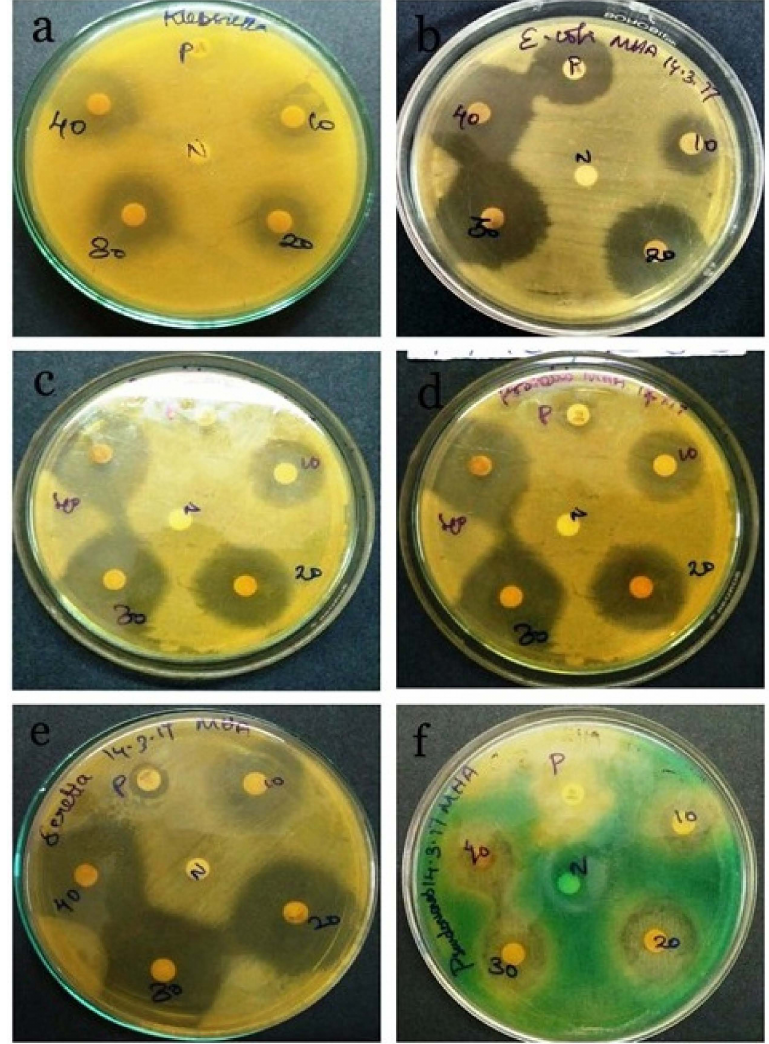
Figure 8. The plates represent the antimicrobial activity of the aqueous extract of Spirulina laxissima against different bacterial pathogens. The zone of inhibition of Spirulina extract against ( a ) Klebsiella pneumoniae ( b ) Escherichia coli ( c ) Staphylococcus aureus ( d ) Proteus vulgaris ( e ) Serratia marcescens ( f ) Pseudomonas aeruginosa